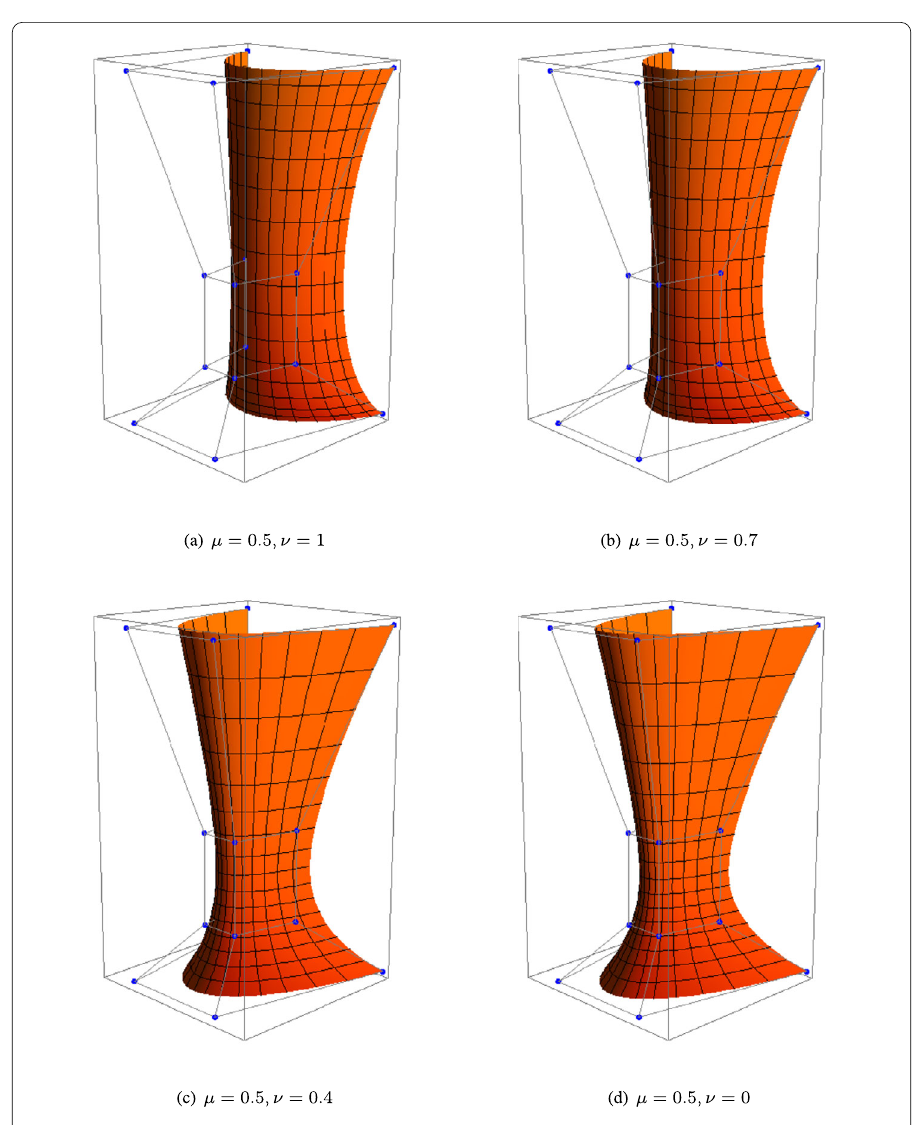
Figure 15 GBT-Bézier swung surfaces with various shape parameter ν